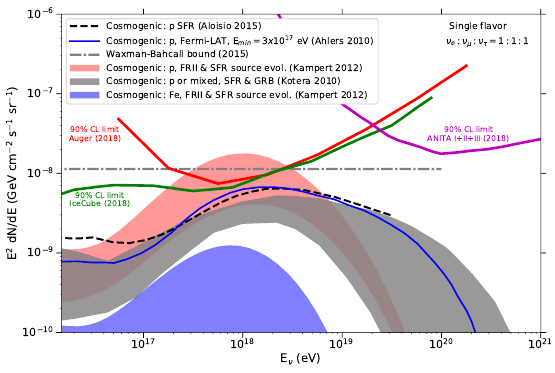
Figure 3. Pierre Auger Observatory di ff erential upper limit (red curve) obtained with data up to 30 June 2018. We also show the most recent limits from ANITA [34] and IceCube [27] exper- iments, along with expected fluxes for several cosmogenic neu- trino models [28–31] as well as the Waxman-Bahcall bound [32]. All di ff erential limits in this plot are given for single flavor and converted to one energy decade. Neutrino flux models are also converted to single flavor when needed. A ν e : ν µ : ν τ = 1 : 1 : 1 flavor ratio at Earth is assumed.